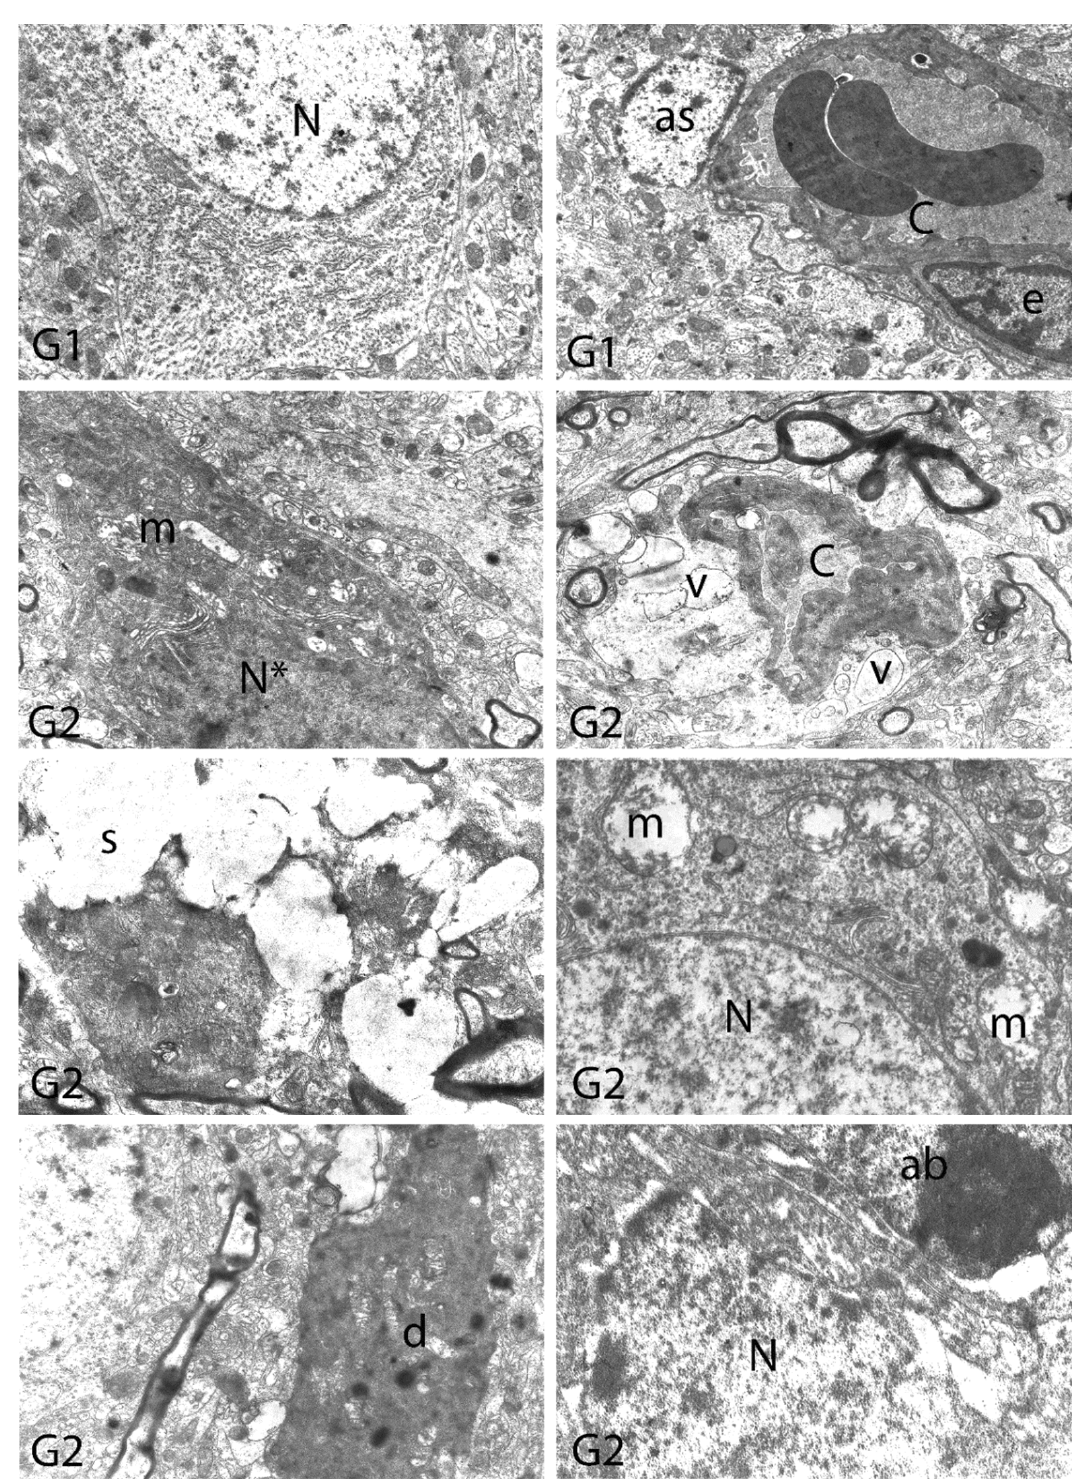
Figure 11. Electron micrographs of rat cerebral cortices from Groups 1 (G1) and 2 (G2). N, nucleus; C, capillary; e, endothelial cell nucleus; as, astrocyte nucleus; N*, pyknotic nucleus of a shrunken electron-dense neuron; m, swollen mitochondria; v, perivascular vacuolization and edema; s, swollen cytoplasm; d, neuronal debris; ab, apoptotic body. Group definitions are as in Figure 9.